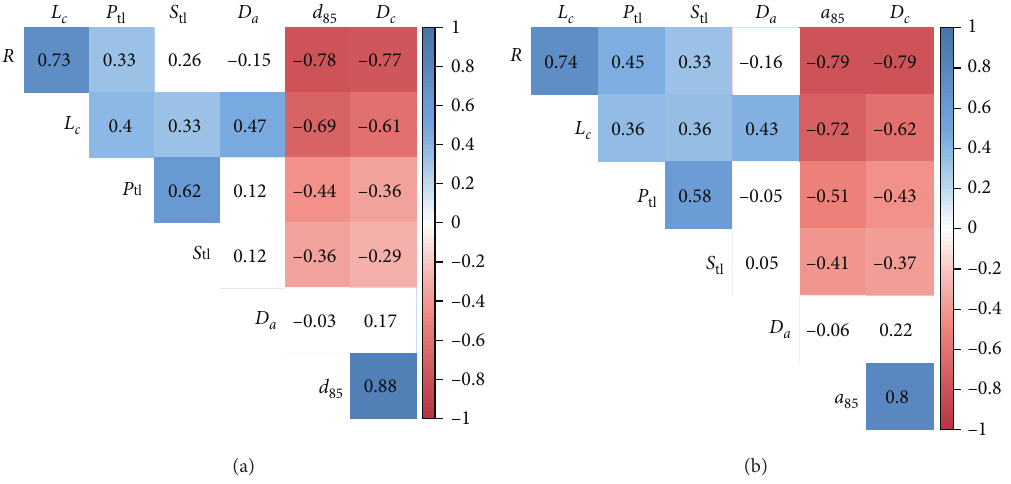
Figure 4: Bivariate correlation matrix: (a) deceleration rate and (b) acceleration